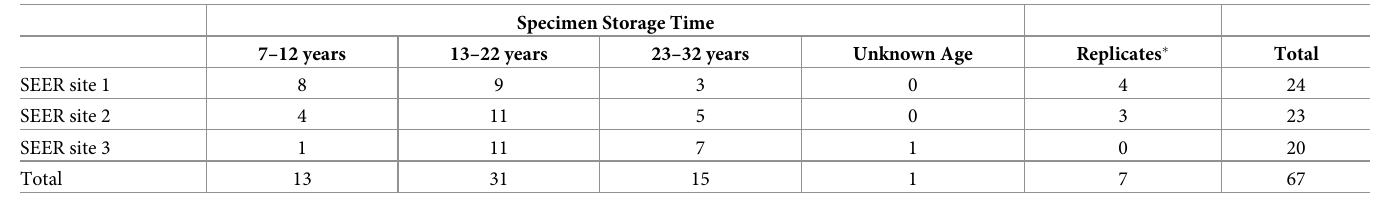
Table 1. FFPE specimens selected for